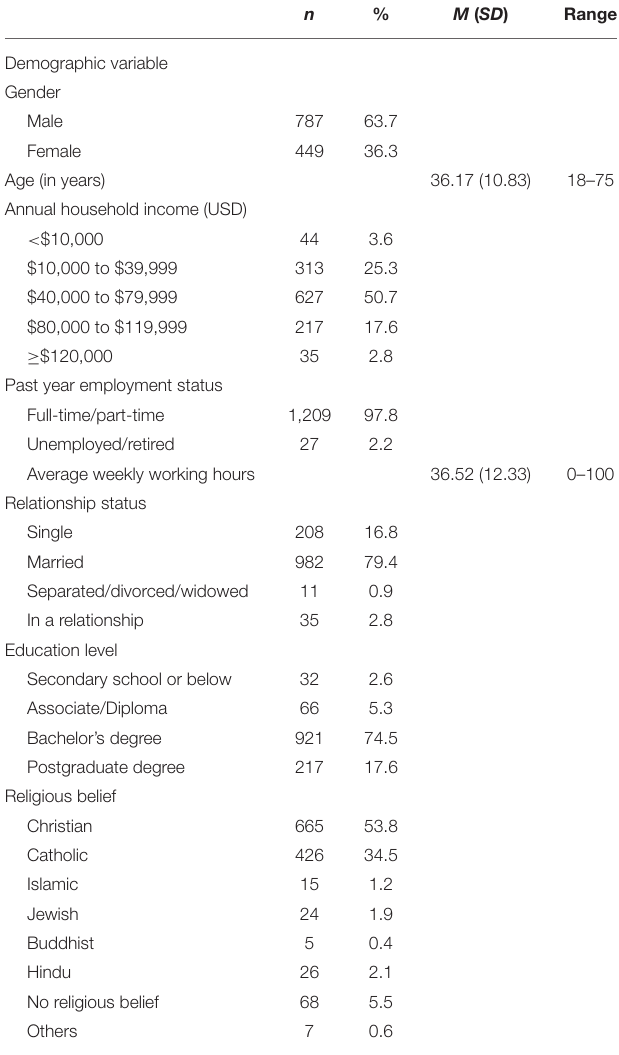
TABLE 1 | Descriptive statistics of demographics of US